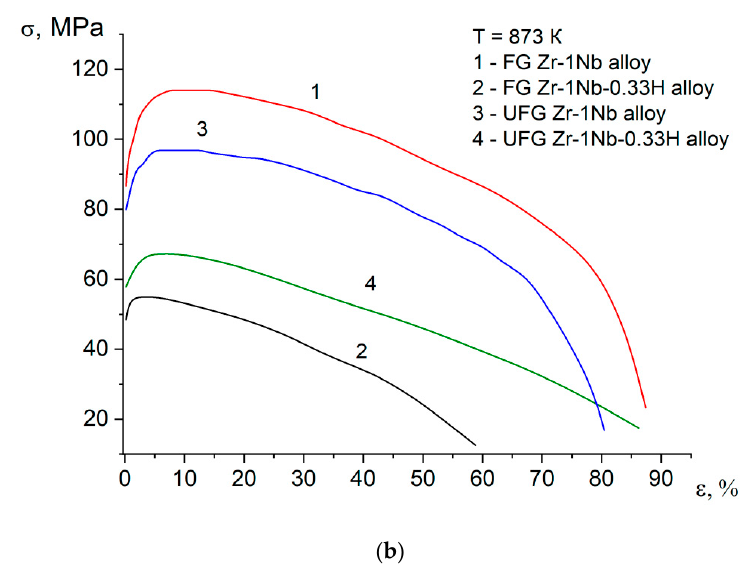
Figure 7. Stress–strain curves at ( a ) 293 K and ( b ) 873 K for the FG and UFG Zr–1Nb and Zr–1Nb–0.33H alloys.